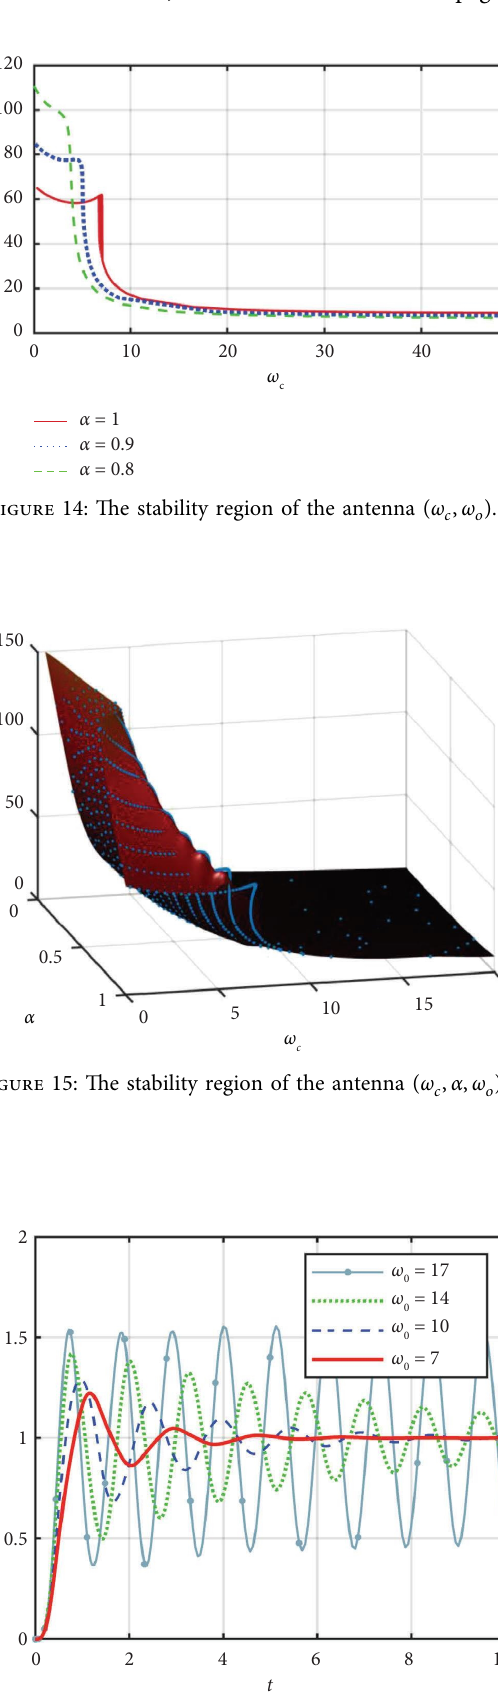
Figure 16: Te step response for the